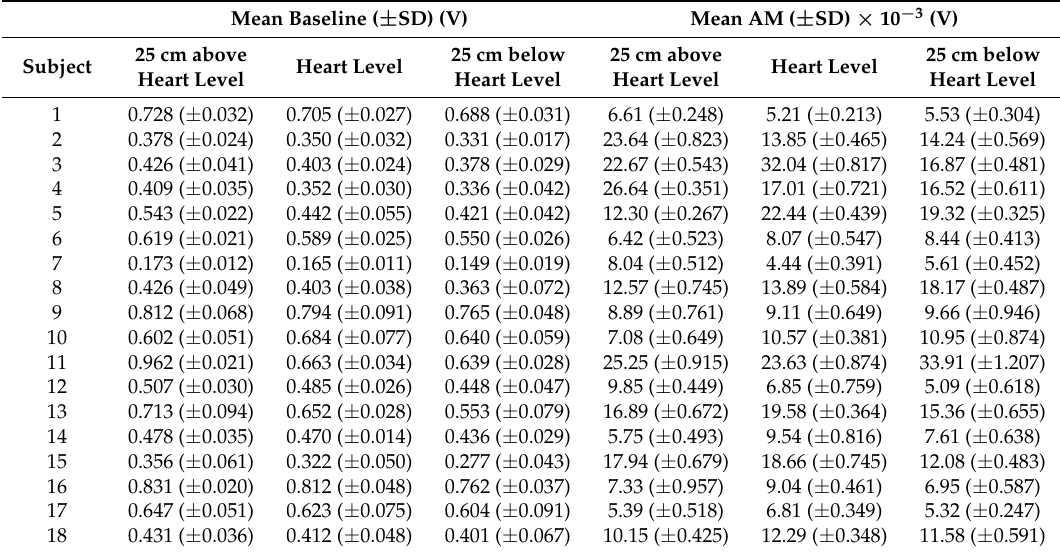
Table 2. Mean BLs and AMs at Different VHD Values for 18 individual subjects were in the sitting position and the finger sensor probe set at three different vertical